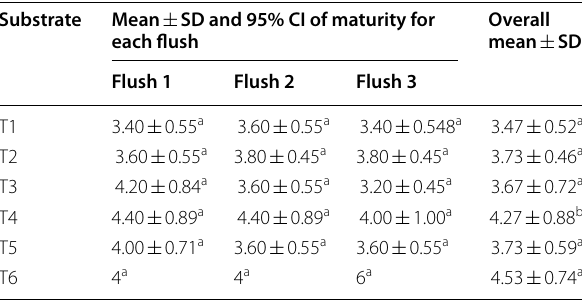
Mean values followed by different superscript letters within a row and columns are significantly different (p < 0.05)